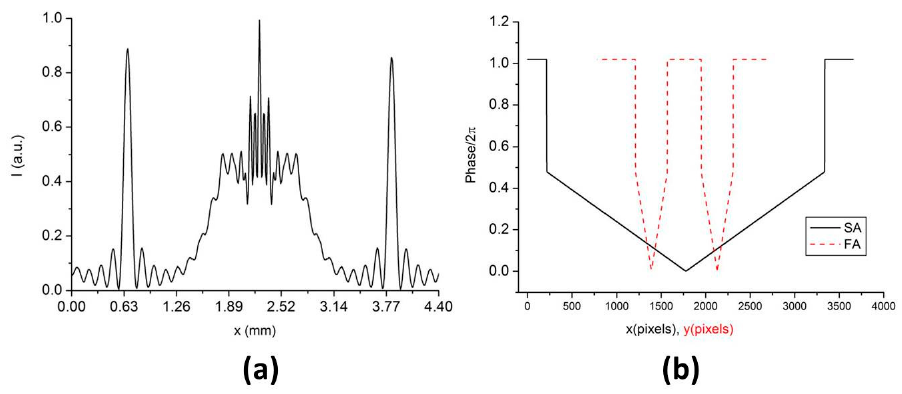
Figure 4. Simulation of the beam propagation for configuration Com 1 . ( a ) Distribution approximately corresponding to the experimental conditions for Figure 3c; ( b ) cuts through the fast axis (FA) and slow axis (SA) phase profiles of the elliptical axicons.